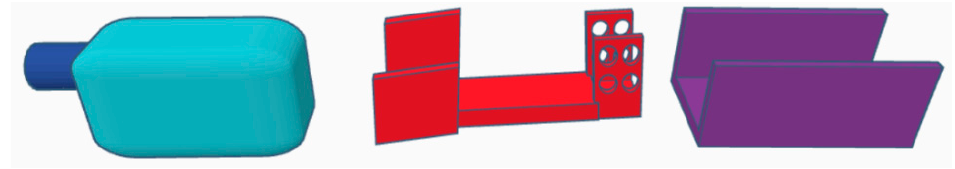
Figure 2. Parts of the exoskeleton for the elbow joint.